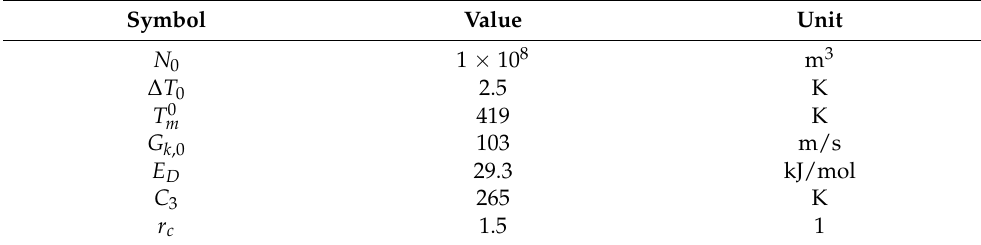
Figure 2. Half-crystallization temperature compared to experimental data. Table 1. Crystallization